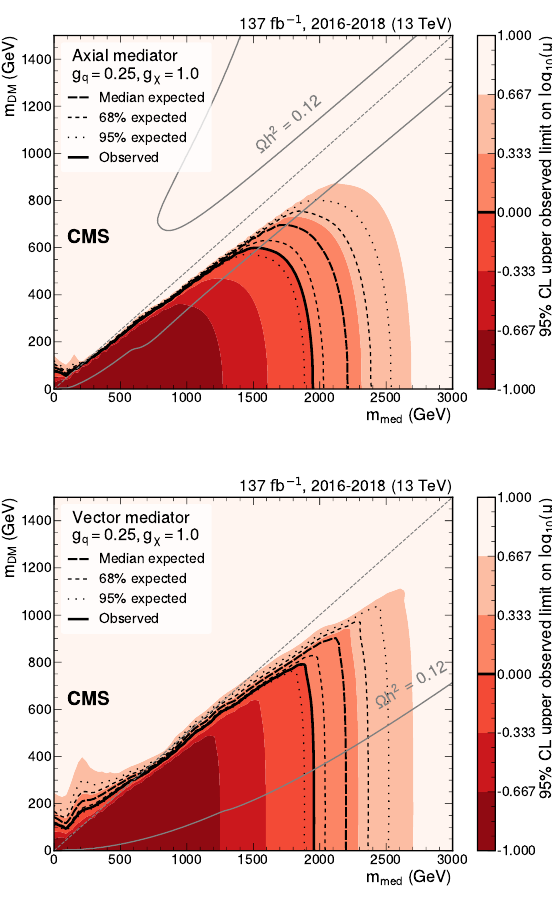
in the m - m plane Figure 7 . Exclusion limits at 95% CL on the signal strength µ = σ/σ theo med DM for coupling values of g = 0 . 25 and g = 1 . 0 for an axial-vector (upper) or vector (lower) mediator. q χ The black solid line indicates the observed exclusion boundary µ = 1 . The black dashed and dotted lines represent the expected exclusion and the 68 and 95% CL intervals around the expected boundary, respectively. Parameter combinations with larger values of µ (indicated by a darker shade in the color scale) are excluded. The observed exclusion reaches up to m = 1 . 95 TeV (2.2 TeV med expected) for low values of m = 1 GeV . The gray dashed line indicates the diagonal m = DM med 2 m , above which only off-shell mediator production contributes to the jet+ p miss final state. The DM T steep increase of the signal strength limit above the diagonal leads to fluctuations of the exclusion contour, which are due to finite precision in the interpolation method in this region. The gray solid lines represent parameter combinations for which the simplified model reproduces the observed DM relic density in the universe under the assumption of a thermal freeze-out mechanism [64,